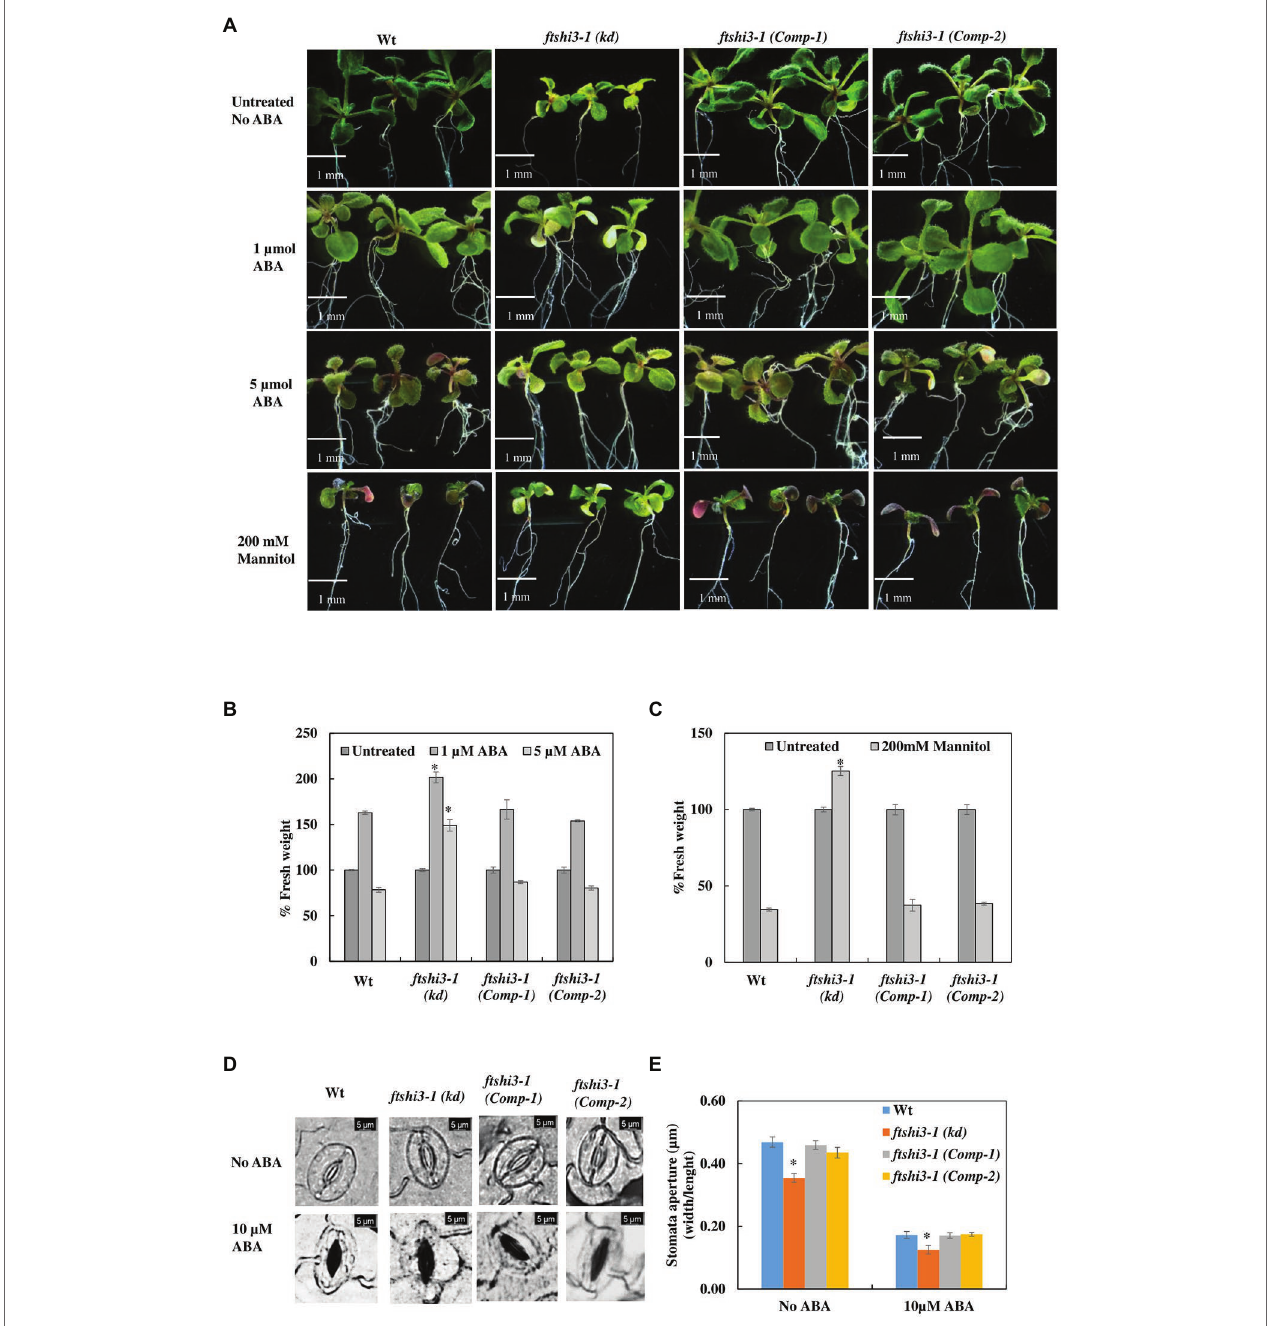
FIGURE 5 | (A) Seedlings of Wt, ftshi3-1(kd) , and ftshi3-1 (Comp-1 and Comp-2) grown in the absence of exogenous ABA and mannitol or exposed to 1or 5 μ M ABA or 200 mM mannitol. (B,C) Quantification of fresh weight after treatment with 1 or 5 μ M ABA or 200 mM mannitol. Asterisks indicate the significant difference to Wt ( * p < 0.05, Student’s t test, three sets containing 15 biological replicates each per treatment per genotype). Scale bar: 1 mm. Error bars represent the SE. (D) Microscopic images of stomatal closure in the presence or absence of 10 μ M ABA in Wt, ftshi3-1(kd) , and ftshi3-1 (Comp-1 and Comp-2) plants. Scale bar: 5 μ m. (E) Graphical presentation of the stomatal closure in the presence or absence of 10 μ M ABA in Wt, ftshi3-1(kd) , and ftshi3-1 (Comp-1 and Comp-2) plants. Asterisks indicate significant differences (Student’s t test, * p < 0.05, five biological replicates; 45 stomata per leaf). Error bars represent the